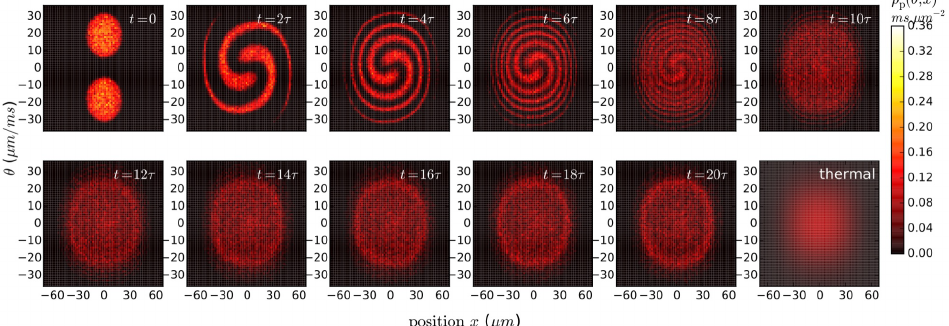
Figure 8: Comparison of the “stationary state” obtained numerically at t = 20 τ , and of the thermal distribution with the same number of particles and the same total